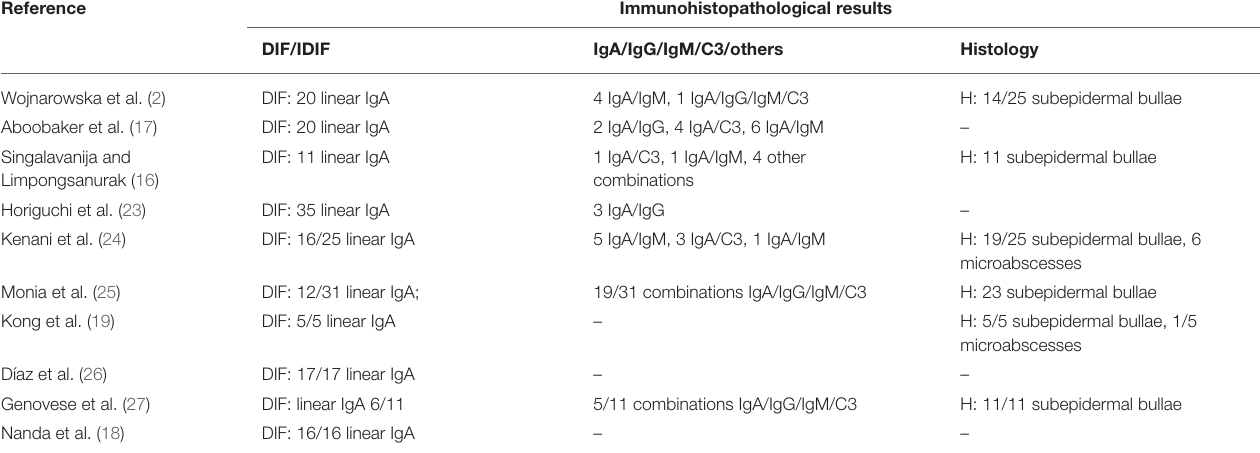
TABLE 2 | Pediatric cases of LABD: immunohistological findings.